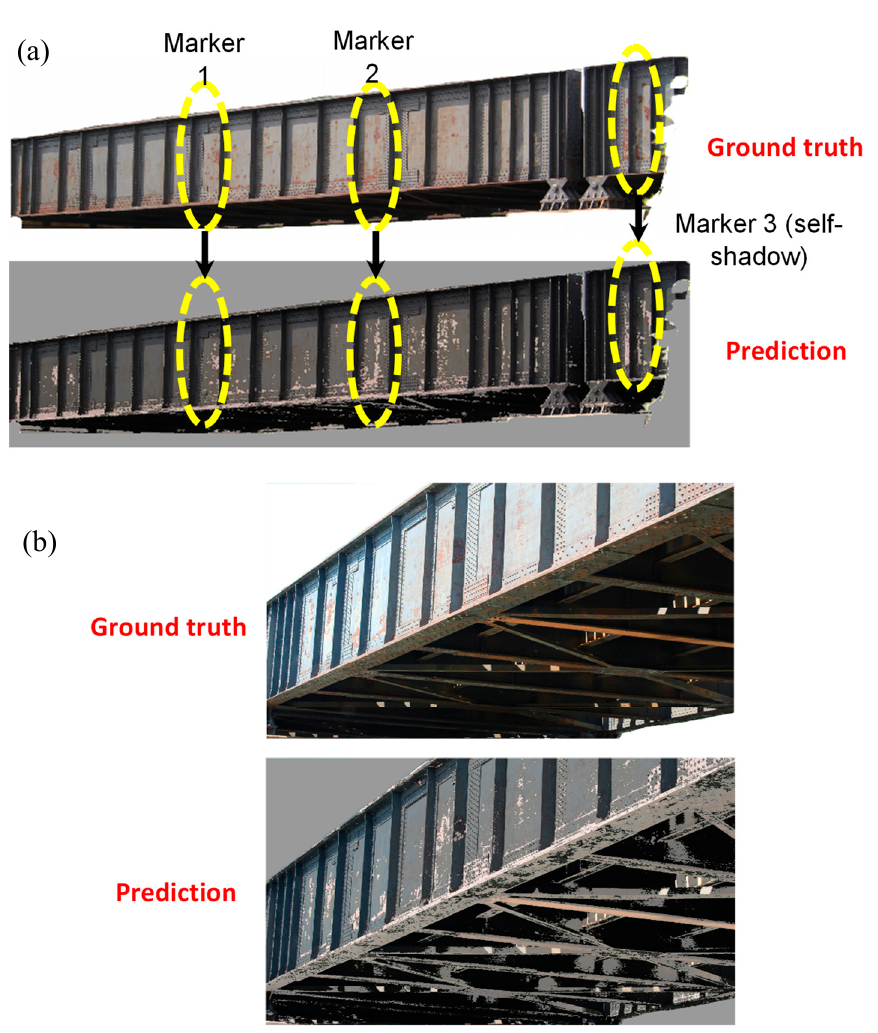
Figure 11. Identification of corrosion in the steel bridges using the single hidden layer with 4 neurons (1st HL(4N)) MLP Configuration. ( a ) steel plate girders with naturally varying illumination and self-shadows, ( b ) bottom side of the deck of the bridge with dark self-shadows.